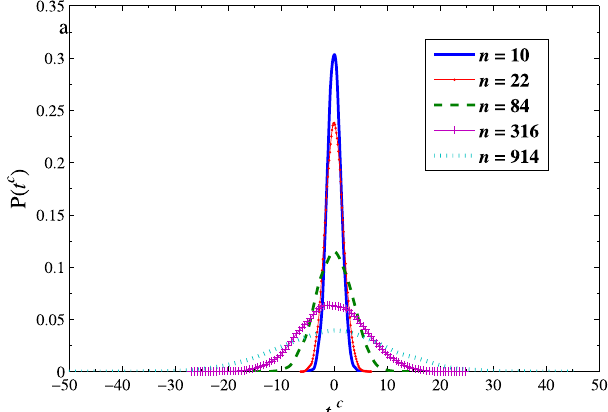
Figure 7. PDF of critical points t - statistics critical values at different scales for the statistical test with 10000 times of the shuffled PM2.5 series of fall.